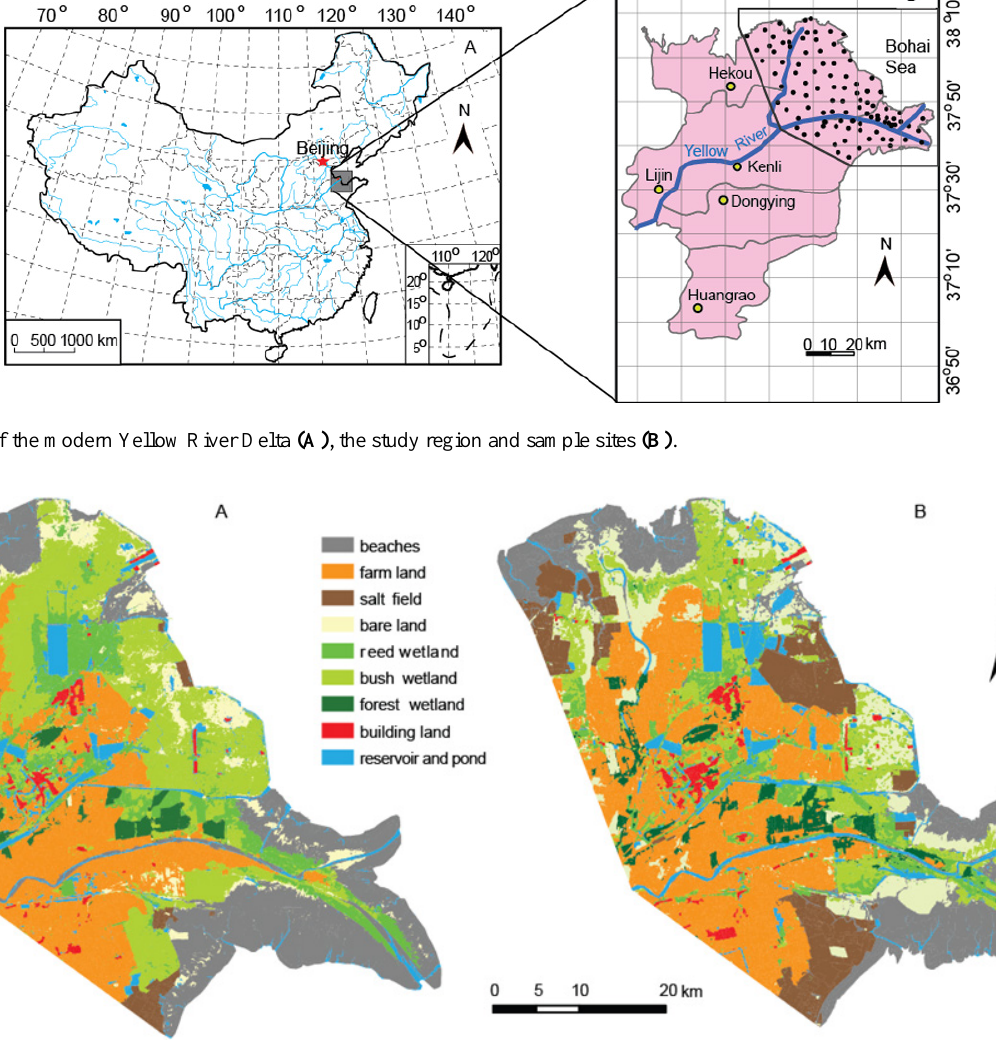
Fig. 2. The landscape types of study area in 2000 (A) and 2009 (B)